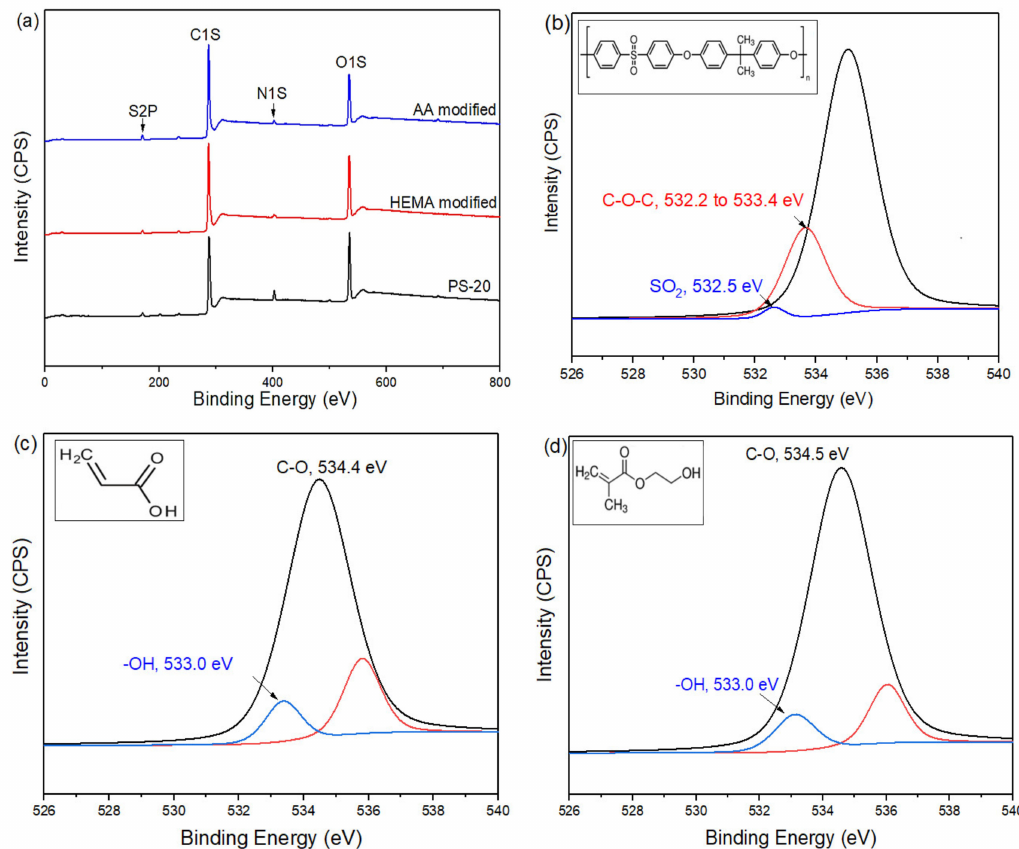
Figure 5. XPS wide scans of ( a ) the control membrane (PS-20) and modified membranes and high-resolution O1s spectra of ( b ) the control (Inset: Organic structure of PSf), ( c ) AA-modified (inset: organic structure of AA), and ( d ) HEMA-modified membranes (inset: organic structure of